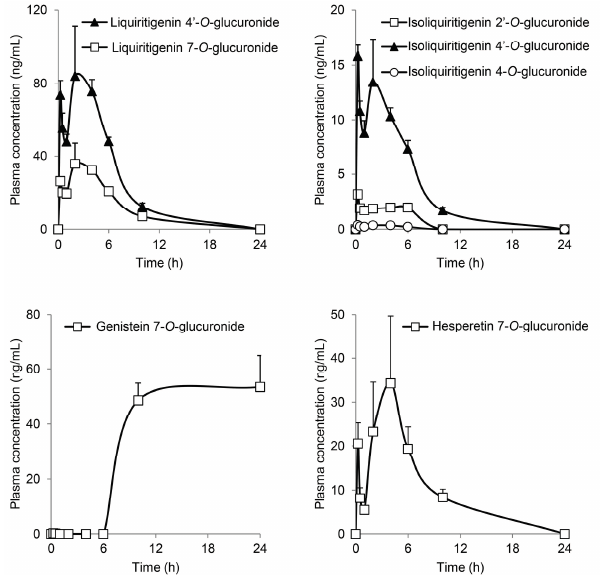
Figure 3. Time course of flavonoid glucuronides in the plasma of JHT-treated rats. Glucuronides of liquiritigenin, isoliquiritigenin, genistein, and hesperetin were measured in the plasma after JHT administration by LC-MS/MS. Each data point represents the mean ± S.E. of triplicates.